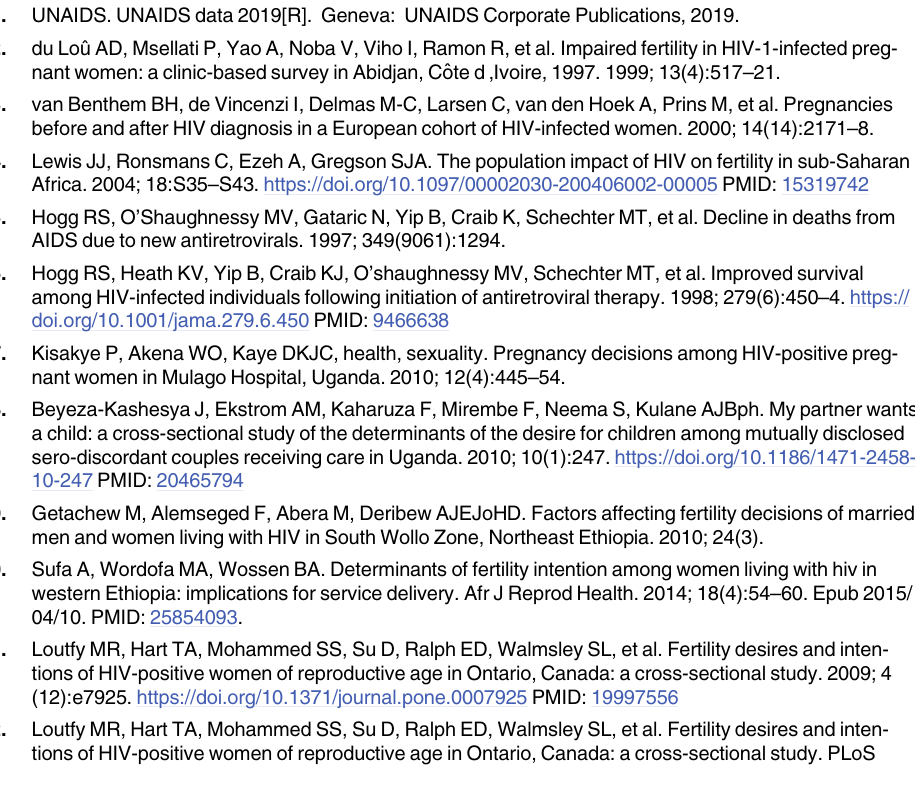
S5 Fig. Funnel plot of publication bias of the studies included in the analysis of the associa- tion of fertility desire with educational level. S6 Fig. Funnel plot of publication bias of the studies included in the analysis of the associa- tion of fertility desire with the number of